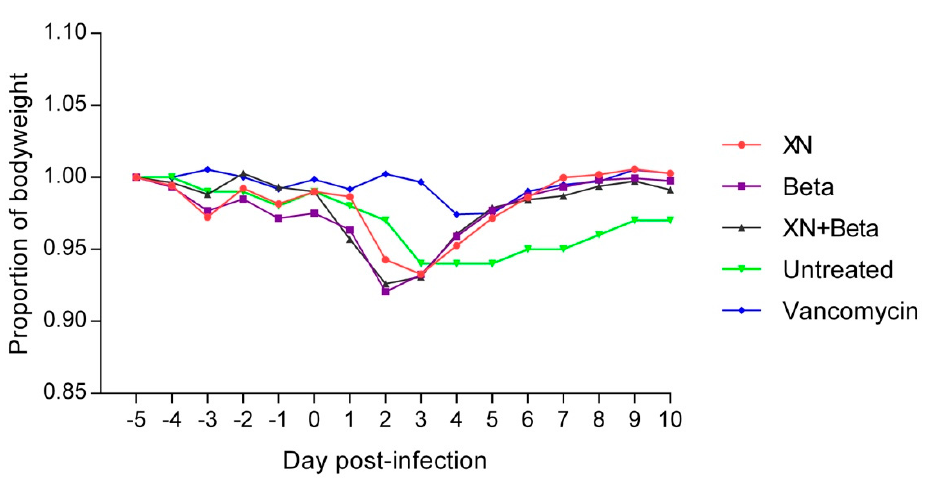
Figure 1. The proportion of body weight of infected rats during the C. difficile infection. Data are presented as means of the animal body weights at the individual time points relative to their body weight at the onset of the experiment (day -5). The animals were infected on day 0, and treatments started on day 3. XN—xanthohumol, Beta—beta-acids.